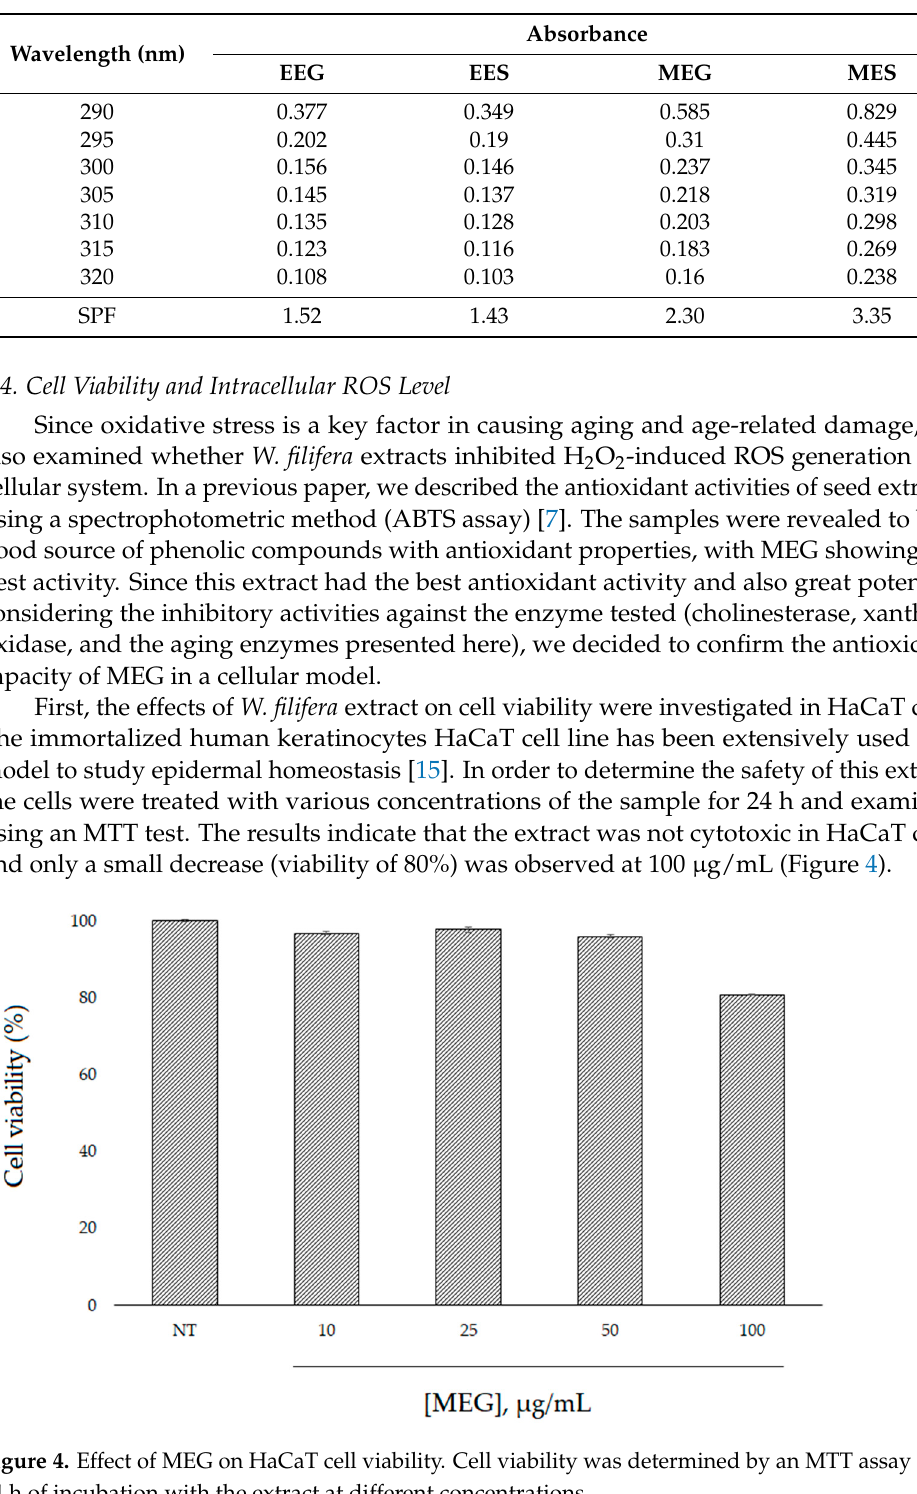
Table 3. Absorbance and sun protection factor (SPF) values of ethanolic and methanolic extracts of W. filifera .